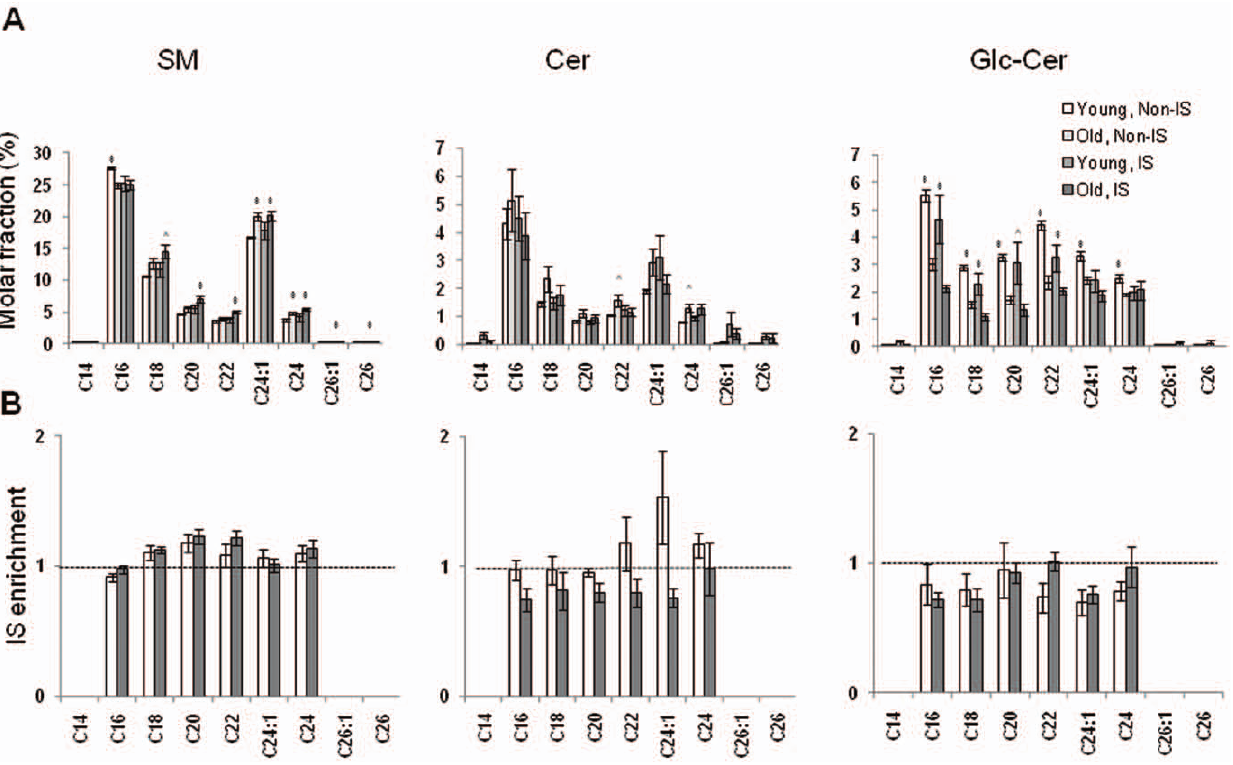
Figure 5. Subspecies analysis indicates that the reduced mole fraction of Glc-Cer in aged CD4 + T cells is driven by the loss of short chain Glc-Cer. ( A ) Relative abundance (molar fraction) of individual subspecies of SM, Cer, and Glc-Cer in young and old CD4 + T non-IS and IS fractions in relation to the total sphingolipid content (* p , 0.05, ‘ p , 0.1 between age groups). ( B ) Relative enrichment of individual subspecies of SM, Cer, and Glc-Cer in young and old CD4 + T cell immune synapses in relation to the non-IS fractions. Fold enrichments are not shown unless the molar abundance of a species in the non-IS fraction exceeds 2 pmol. This limits the appearance of artifacts due to low signal-to-noise in the denominator. A dashed horizontal line indicates where this value is 1 (equivalent molar proportions in the IS and non-IS fractions). Values above 1 are indicative of IS enrichment. Values lower than 1 are indicative of poor retention in the IS fraction.